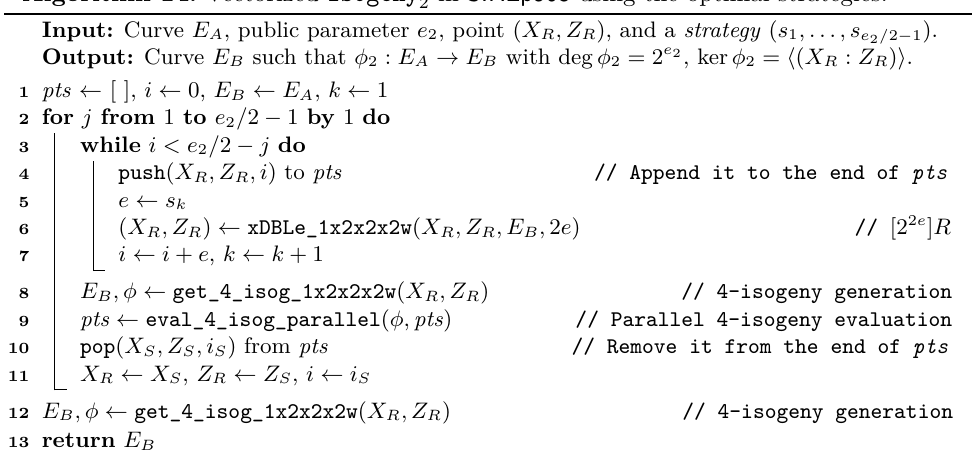
Algorithm 14: Vectorized isogeny